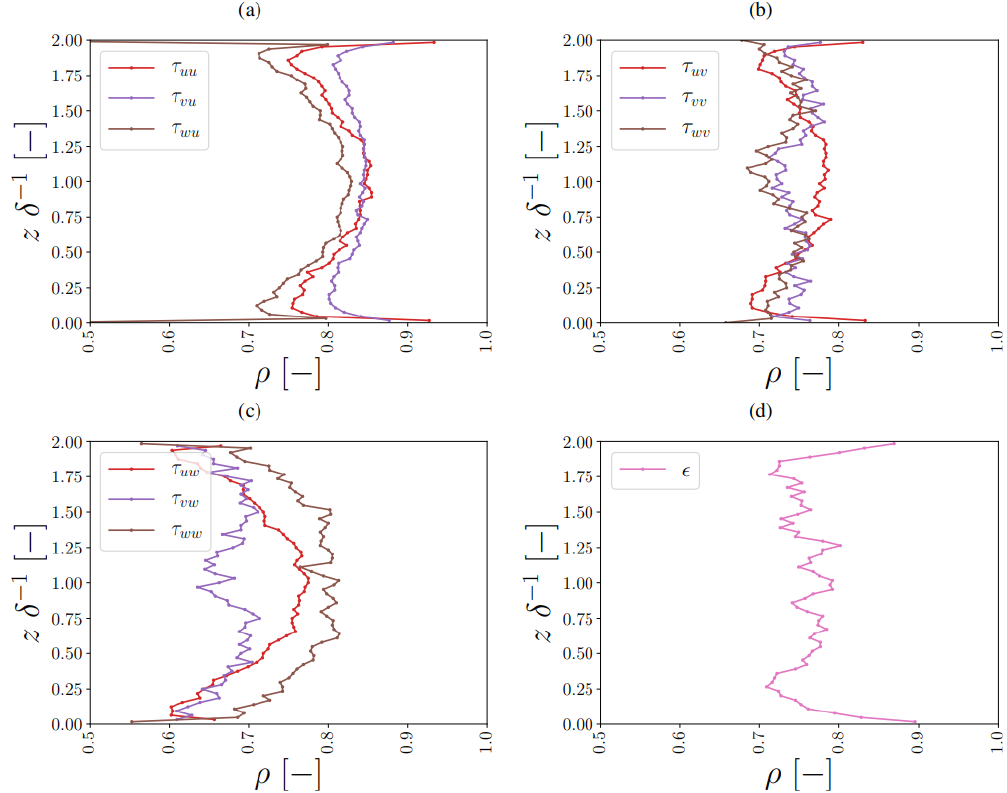
Figure 12. Vertical profiles of correlation coefficients between ANN predictions and DNS values for all correction and dissipation terms (a– d) at one representative time step not used to train and validate the ANNs. Here, the j index refers to the considered control volume (Sect. 2). The heights are normalized by the half-channel width δ − 1 . Note that the τ uw,vw components are left out at the first vertical level, as these are due to the staggered grid located exactly at the bottom wall. At the bottom wall, we imposed a no-slip boundary condition, meaning that these components are by definition